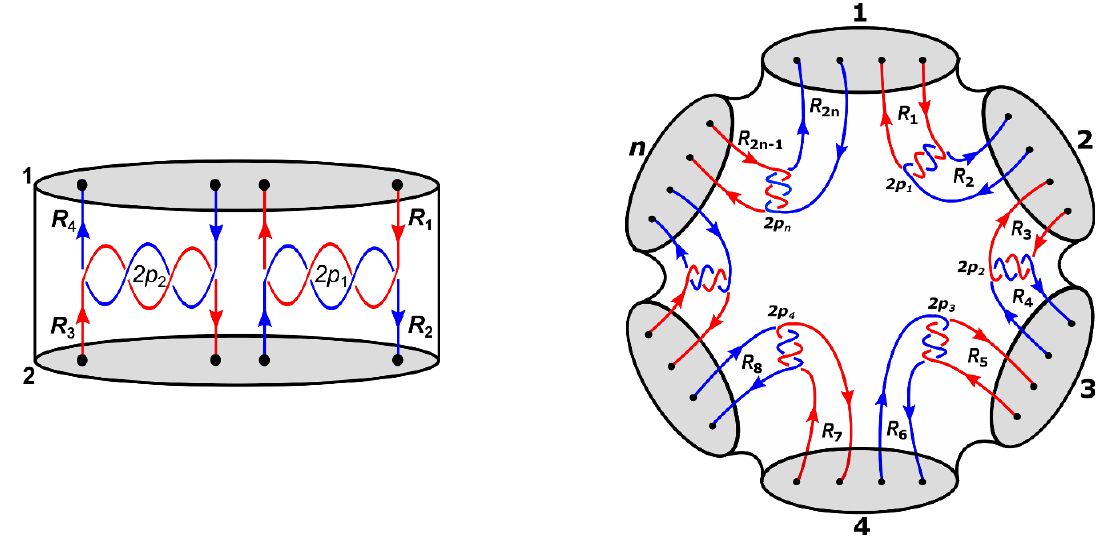
Figure 14 . The quantum state Ψ on n copies of S 2 . The Wilson lines carrying representations 4 (cid:30) | and R braid 2 p number of times ( j = 1 , 2 , . . . , n ). The figure on the left is the state for R 2 j 1 2 j j − n =